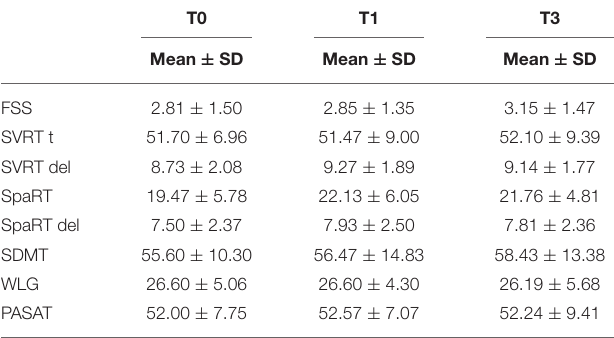
TABLE 4 | Results of BRBNT in the study group at baseline and during the follow-up. T0 T1 T3 Mean ± SD Mean ± SD Mean ± SD FSS 2.81 ± 1.50 2.85 ± 1.35 3.15 ±